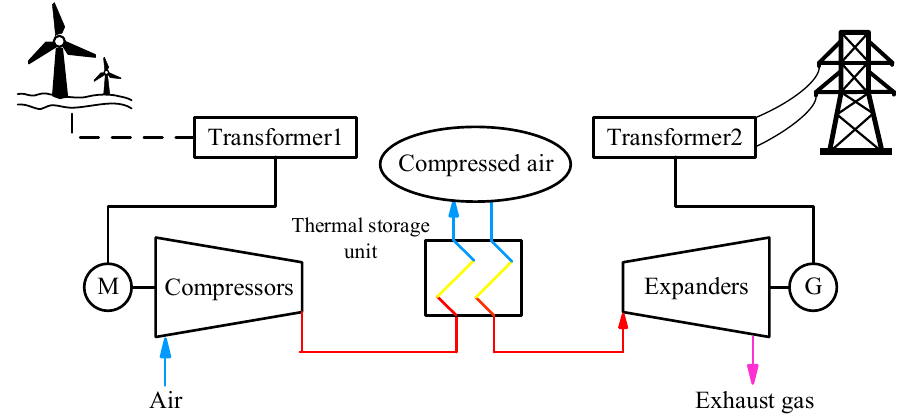
Figure 8. The basic workflow of offshore compressed air energy storage [49].